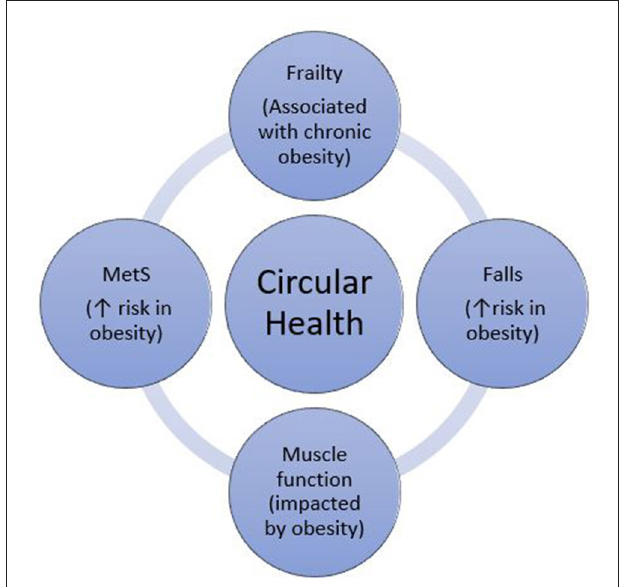
FIGURE 1 | The role of circular health: assessment of frailty, falls, muscle function and Metabolic Syndrome (MetS), in the context of